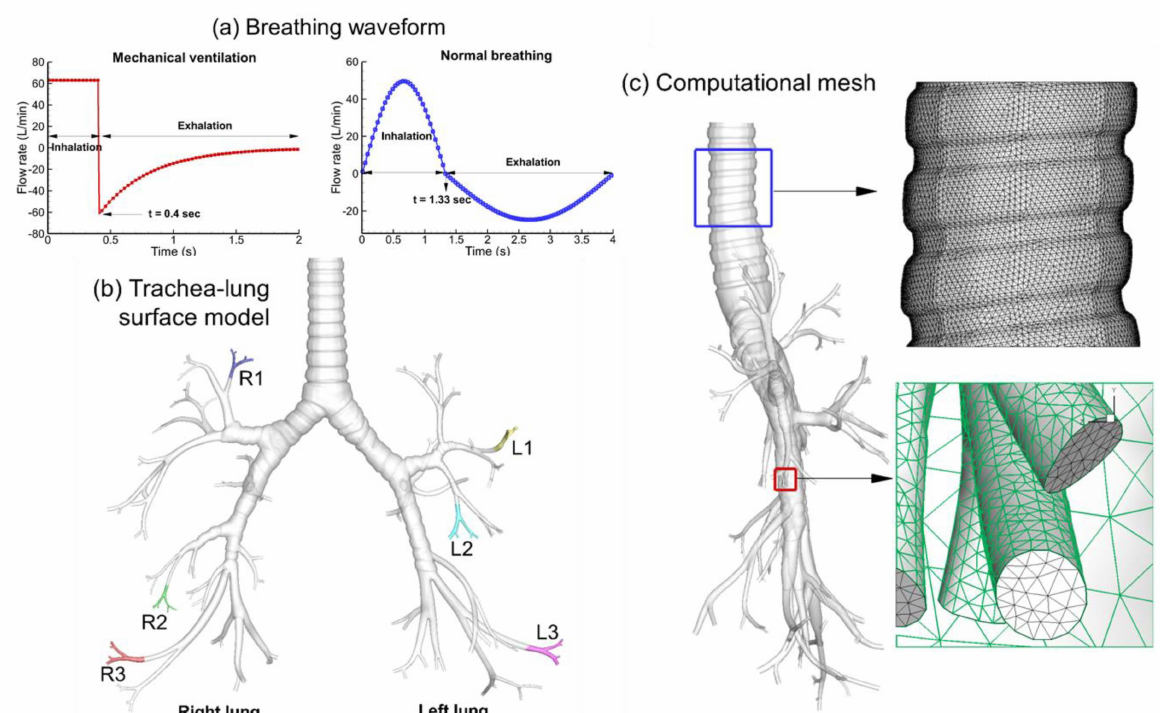
Figure 1. Imaged-based realistic trachea whole lung airway model: ( a ) breathing waveform of flow rate for mechanical ventilation (MV) and normal breathing (NB); ( b ) surface geometry model; and ( c ) computational mesh. The mesh contains proximately 3.5 million unstructured tetrahedral